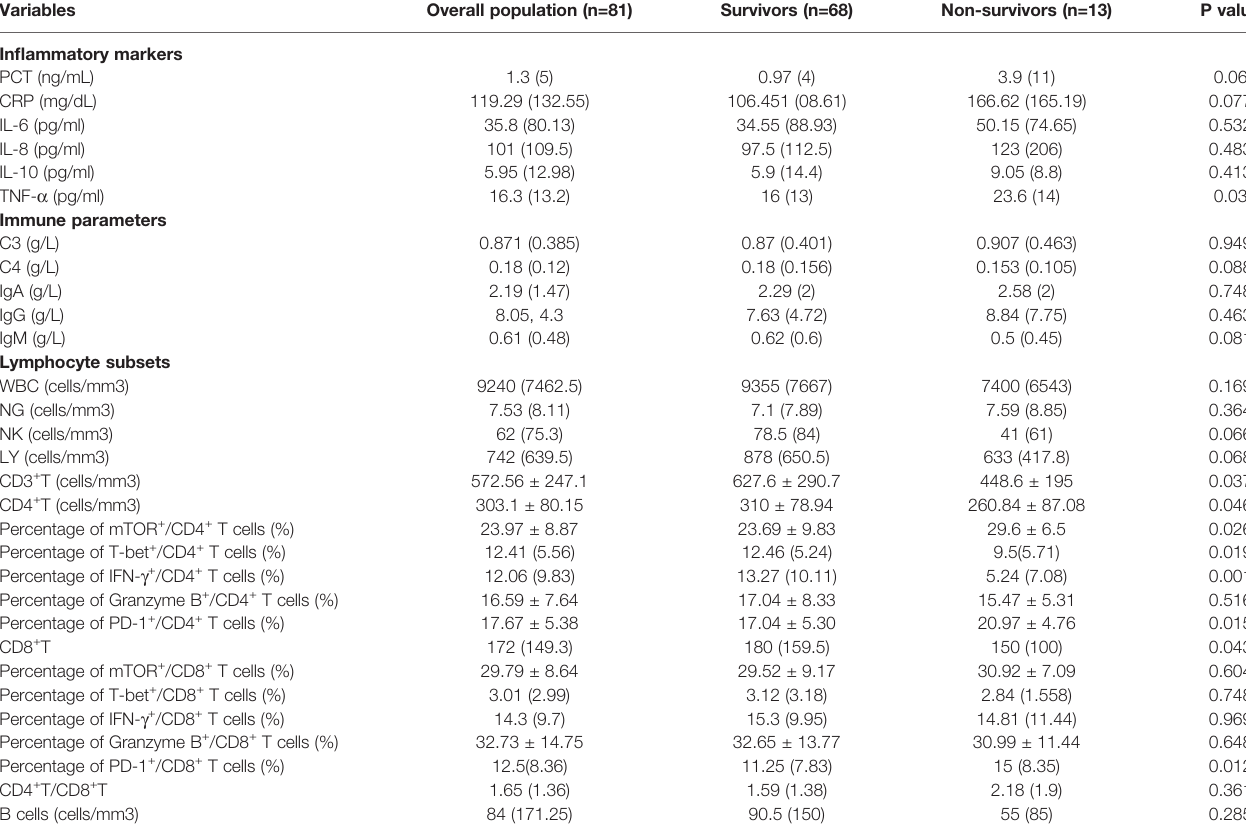
TABLE 2 | Comparison in Immune biomarkers of septic patients based upon 28-day mortality.